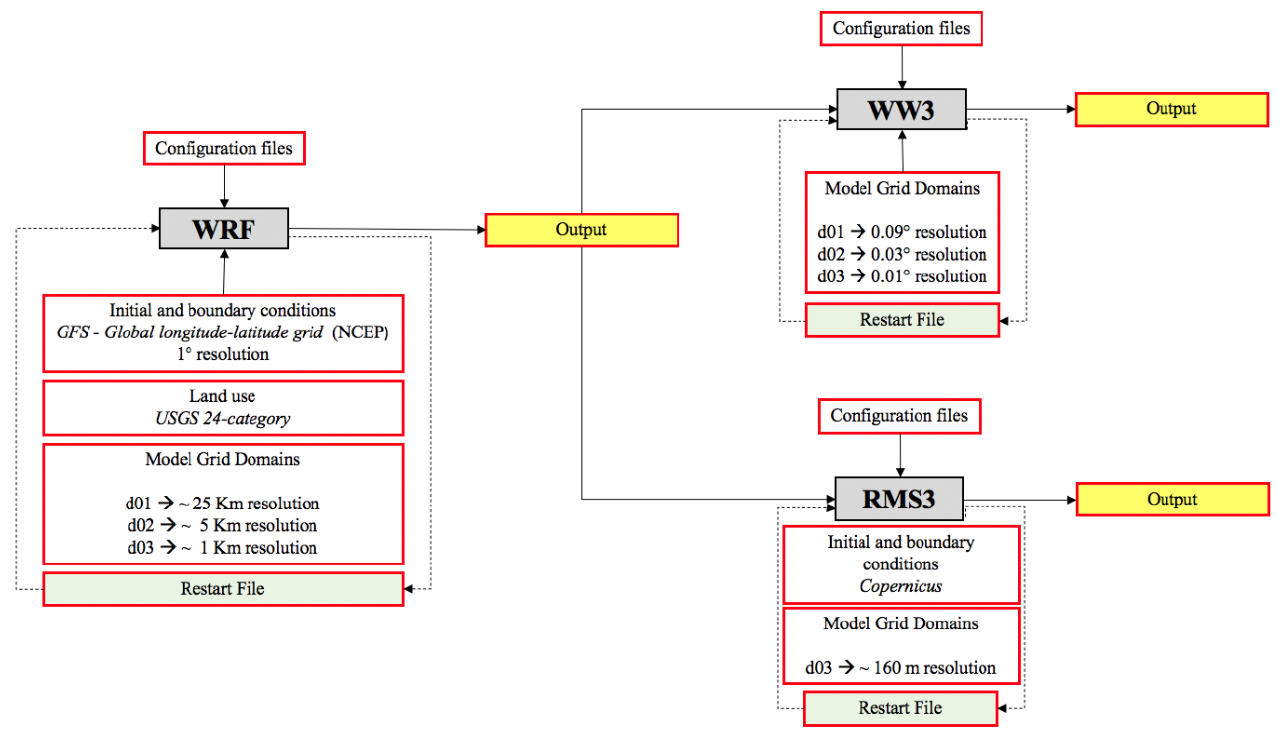
Figure 2. Block diagram of the model chain and of their mutual connections. Similarly, we configured three telescopic WW3 computing grids: the ground resolution on the whole Mediterranean area d01 WW3 is 9 km, the resolution for the seas surrounding the Italian peninsula d02 WW3 is set at 3 km, while the east sector of the central and southern Tyrrhenian Sea d03 WW3 is covered at a resolution of 1 km [16]. The configuration of ROMS3 was provided using the sole d03 RMS3 domain covering, at the spatial resolution of approximately 160 m, as the geographic area between the southern Lazio Region (Italy) and the northern Calabria Region (Italy) spanning for more than 100 × 50 nautical miles. Each of the configured models uses 1 h external time steps (with different internal time steps ∆ t for each model and domain) and support a restart mode (see Figure